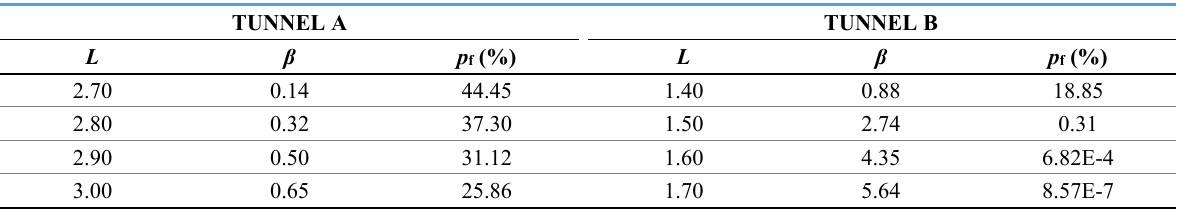
Table 5. Reliability index and failure probabilities of the plastic